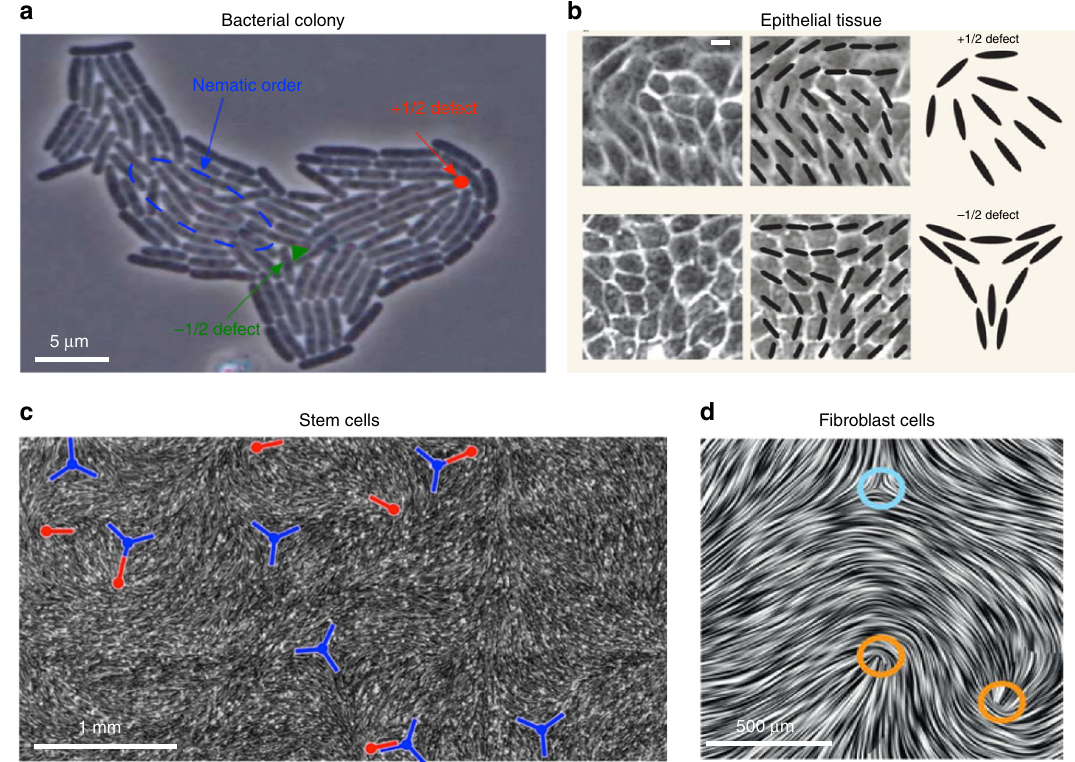
Fig. 4 Active nematic defects in biological systems. a Growing colony of E. coli bacteria 99 (Copyright (2014) by the American Physical Society). The motion of + 1/2 defects towards the growing interface can lead to shape changes of the colony. b Epithelial tissue of Madine – Darby canine kidney (MDCK) cells. Scale bar is 10 μ m 32 (Nature Publishing Group). Strong correlations between the position of + 1/2 defects and cell death and extrusion have been reported. c Monolayer of neural progenitor stem cells 100 (Nature Publishing Group). Cells are depleted from − 1/2 defects (blue, trefoil symbols) and accumulate at + 1/2 ones (red, comet-like symbols). d Dense monolayer of mouse fi broblast cells 57 (Nature Publishing Group) showing − 1/2 and + 1/2 topological defects marked by blue and orange circles,